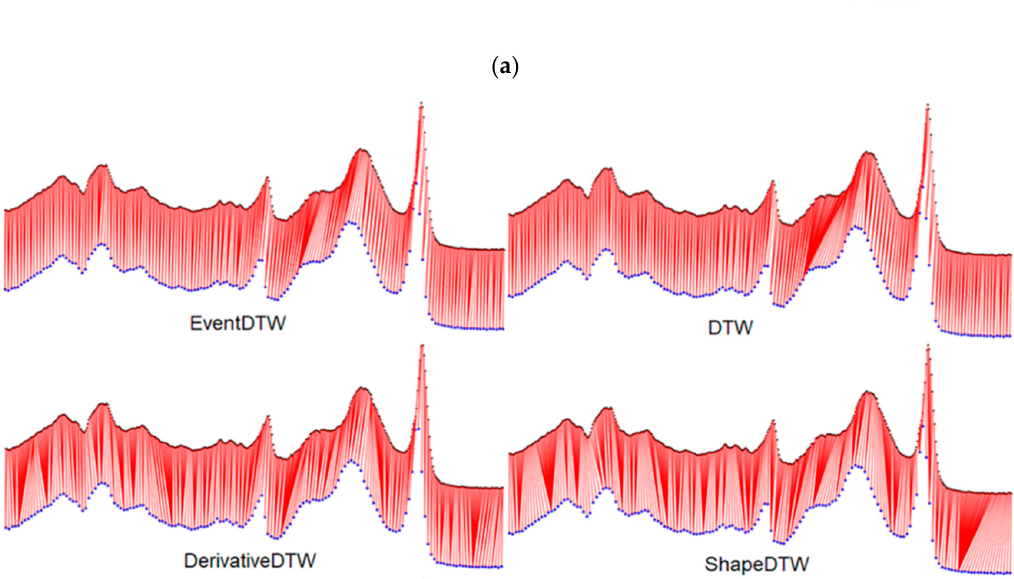
Table 2. Algorithm performances in biomedical dataset [22].